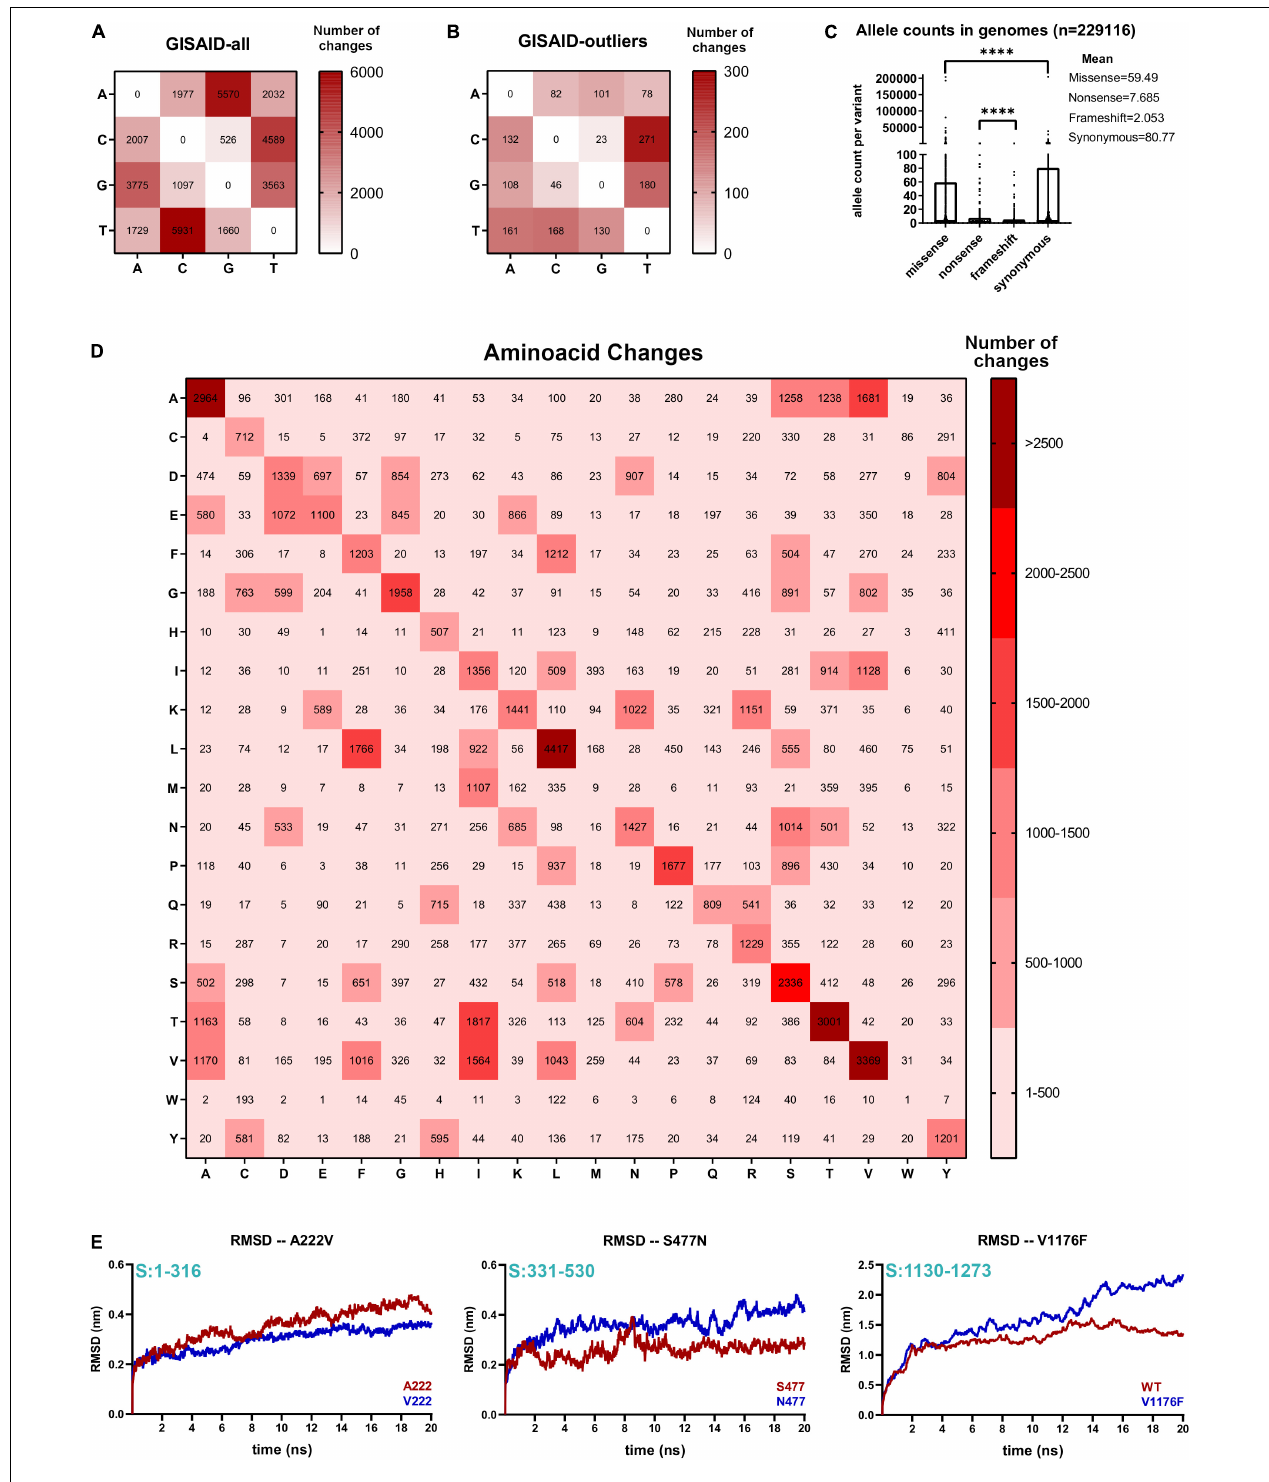
FIGURE 2 | Non-neutral codon changes actively shape evolution of several SARS-CoV-2 proteins. (A) Nucleotide change frequencies from 229,124 aggregated GISAD genome variants annotated with SnpEff program. Frequency boxes are colored from white to dark red as number of changes increase. (B) Same as A for 133 aggregated GISAID genomes, corresponding to GISAID outlier samples. Frequencies boxes are colored from white to dark red, as the number of changes increases. (C) Missense, non-sense, frameshift, and synonymous number of occurrences in 229,124 GISAID genomes. Significance of comparisons were assessed with Mann-Whitney test (**** P < 0.0001, ns P > 0.05). (D) Plot of change frequencies across 20 amino acid changes in SARS-CoV-2.